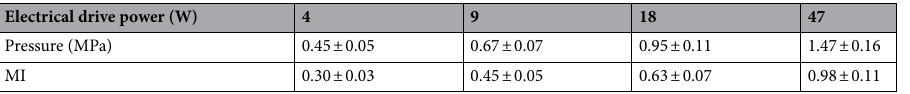
Table 1. Rarefactional pressure maximum and MI at the exterior surface of the EkoSonic catheter over each transducer pair. However, the assumptions about the conditions for cavitation embedded in the definition of the MI are not met 63